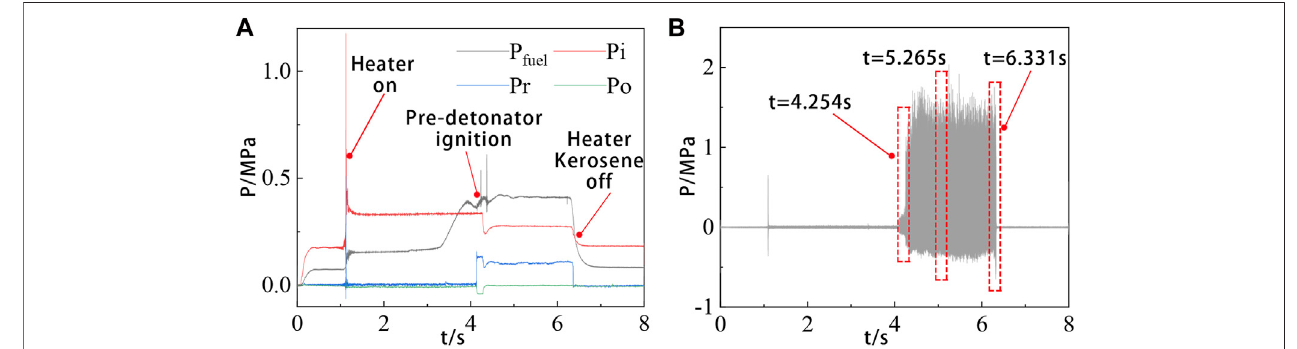
FIGURE 5 | Results of operating at T 0 (cid:1) 650K, _ m air (cid:1) 1 . 5kg/s, and φ (cid:1) 0 . 98.